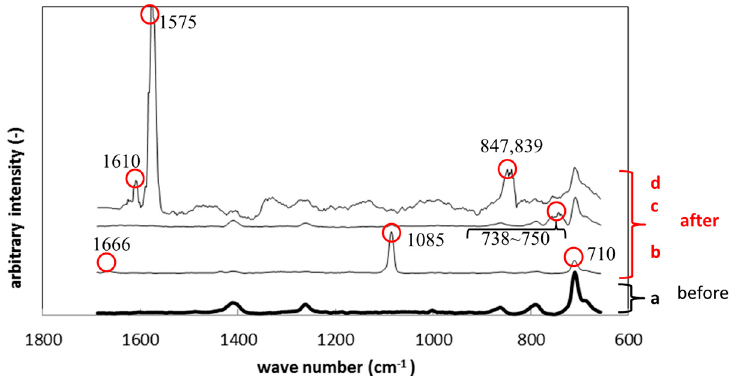
Figure 9. Raman shifts for the silicone specimens before ( a ) and after immersion ( b – d ).